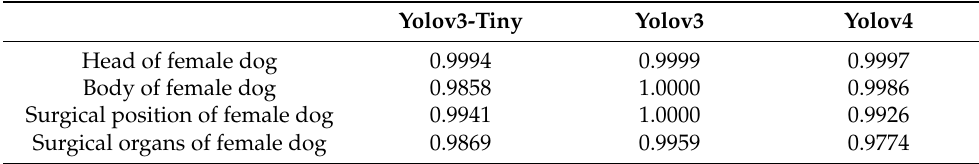
Figure 6. Pictures of the Yolov3-Tiny ( a ), Yolov3 ( b ) and Yolov4’s ( c ) detection for Female Dog. Table 3. Detection performance for female